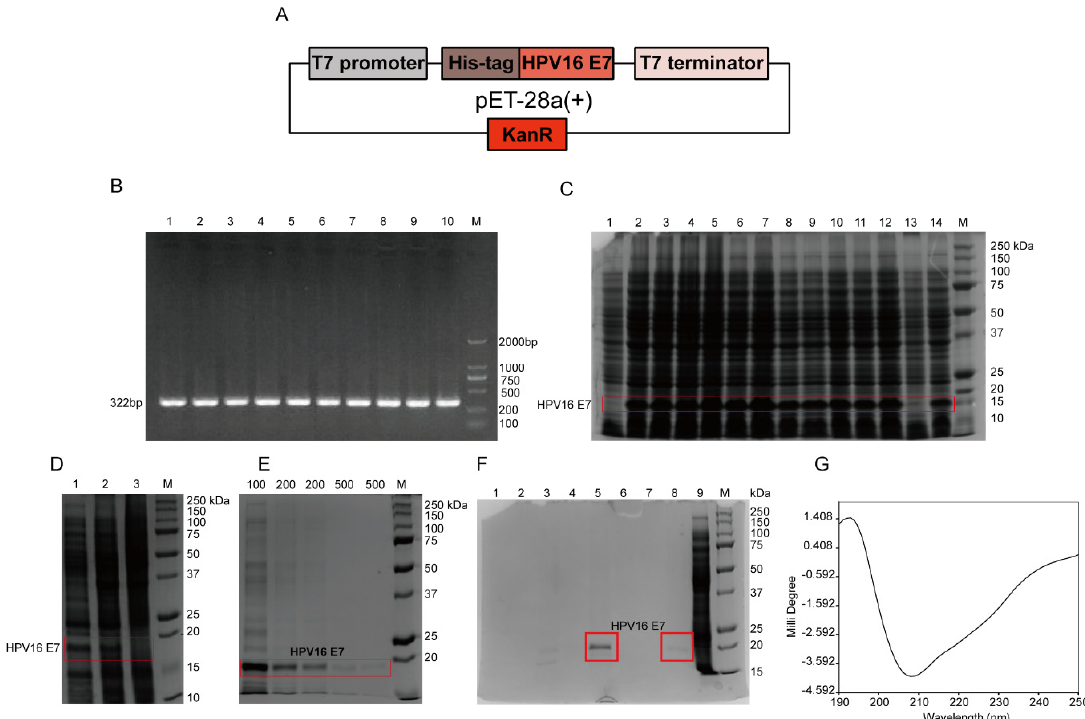
Figure 1. Preparation of the HPV16 E7 ‐ HIS fusion oncoprotein. ( A ) HPV16 E7 gene with T7 promoter, HIS ‐ tag, and kanamycin resistance was recombined into plasmid pET ‐ 28a(+) to construct pET ‐ 28a(+) ‐ HPV16 E7 recombinant plasmid. Different colors represent different protein expressing elements in the vector. ( B ) Amplification of the HPV16 E7 gene by gradient PCR. Lanes 1–10 were the 322bp PCR product of the HPV16 E7 gene at an annealing temperature of 50–70 °C, and M was the DNA Marker DL ‐ 2000. ( C ) 15% SDS ‐ PAGE of the HPV16 E7 fusion oncoprotein ‐ induced expression in prokaryotic cells. M was the protein marker; lanes 1 and 13 were empty carriers; lanes 2–5, 6–9, 10–12, and 14 were samples performed at 16 °C, 30 °C, and 37 °C, respectively, induced by 0.1, 0.5, 0.75, and 1.0 mM IPTG, respectively. The red box represents the bands of HPV16 E7. ( D ) 12% SDS ‐ PAGE of expression form of the HPV16 E7 fusion protein. Lanes 1, 2, 3, and M were bactericidal solution, supernatant, precipitation, and protein marker, respectively. The red box represents the bands of HPV16 E7. ( E ) 12% SDS ‐ PAGE of the HPV16 E7 fusion protein purified by nickel column. Lanes 100, 200, 500, and M were samples performed by using100 mM, 200 mM, and 500 mM imidazole eluate, and protein marker, respectively. The red box represents the bands of HPV16 E7. ( F ) 12% SDS ‐ PAGE of the HPV16 E7 ‐ HIS fusion oncoprotein purified by DEAE column. Lanes 1 to 5 were the 200 mM imidazole ‐ eluted peak sample of the HPV16 E7 protein purified by DEAE column penetration, re ‐ equilibrium, 0.3 M NaCl elution at peak tip, 0.3 M NaCl elution at falling peak, and 0.5 M NaCl elution at peak tip, respectively; lanes 6 to 8 were 500 mM imidazole ‐ eluted peak samples of the HPV16 E7 protein purified by DEAE column penetration, re ‐ equilibrium, and 0.5 M NaCl elution peak tip, respectively; lane 9 was bacterial lysate of the IPTG ‐ induced engineered bacteria pET ‐ 28a(+) ‐ HPV16E7 ‐ Rosetta (DE3) pLysS; M was protein marker. The red box represents the bands of HPV16 E7. ( G ) The purified HPV16 E7 ‐ HIS fusion proteins were determined by circular dichromatography. HPV, human papillomavirus; HIS, histidine; IPTG, isopropyl ‐β‐ d ‐ thiogalactoside.